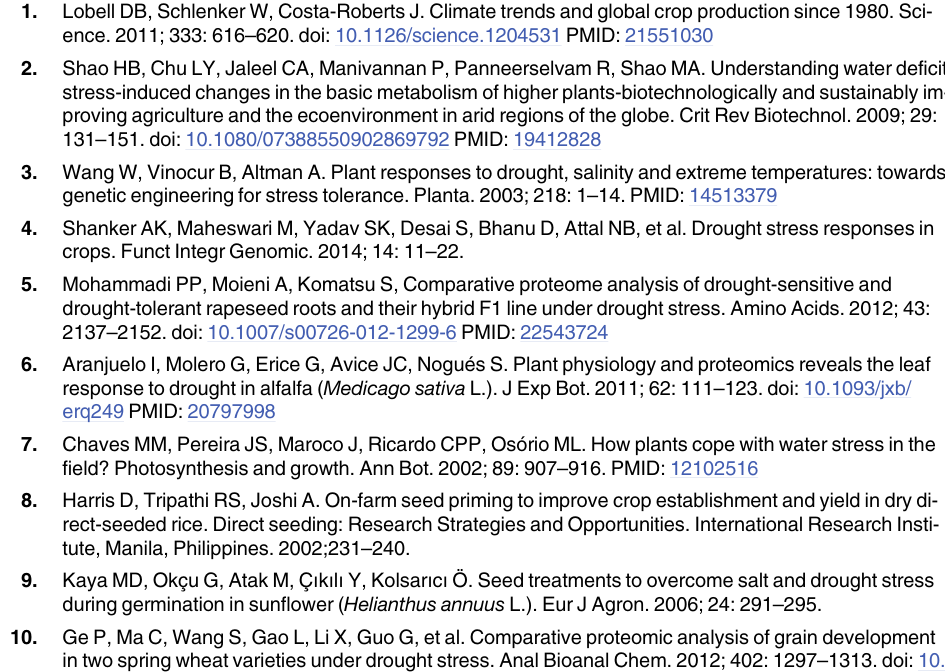
S2 Table. The peptide sequences of all